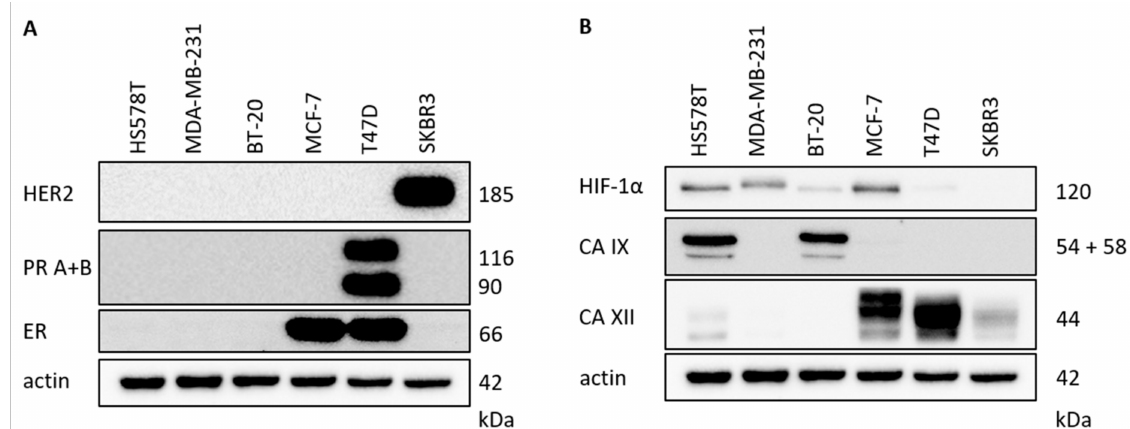
Figure 2. Characterization of human breast cancer cell lines (under normoxic conditions). Characterization of protein expression in six human breast cancer cell lines under normoxic conditions by use of Western blot. The detection of hormone receptors progesterone (PR A+B) and estrogen (ER) as well as HER2 ( A ). Protein levels of HIF-1 α , CA IX and CA XII are shown ( B ). Actin was used as the loading control. The figure shows a representative Western